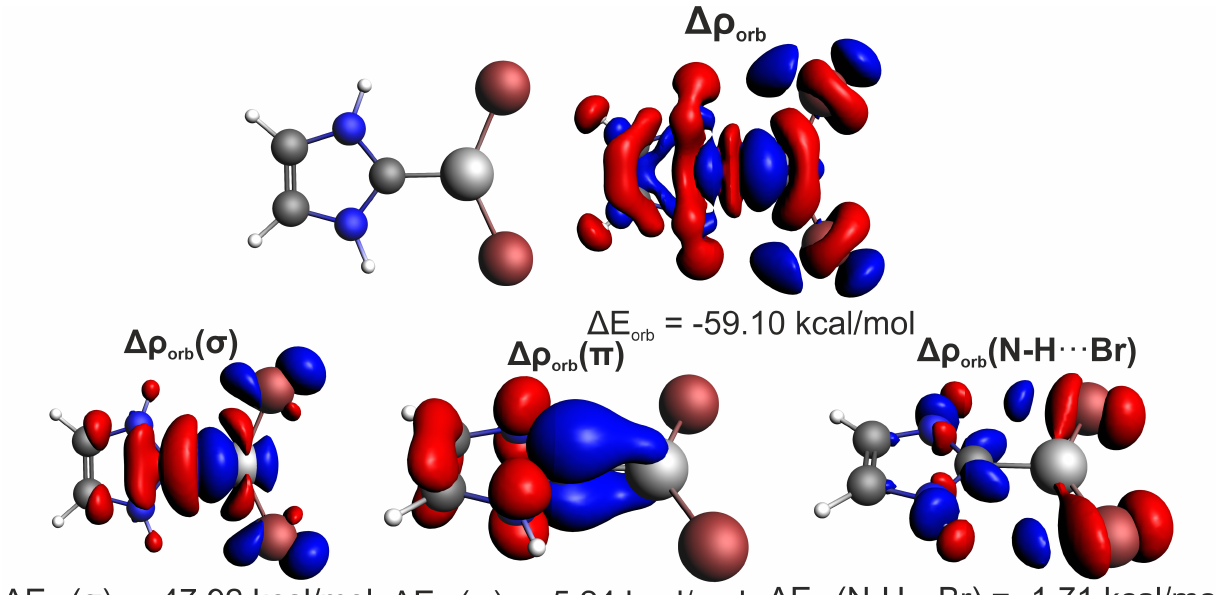
Figure 2. Dominant NOCV-based deformation density contributions determined for imidazol-2- ylidene · · · BeBr 2